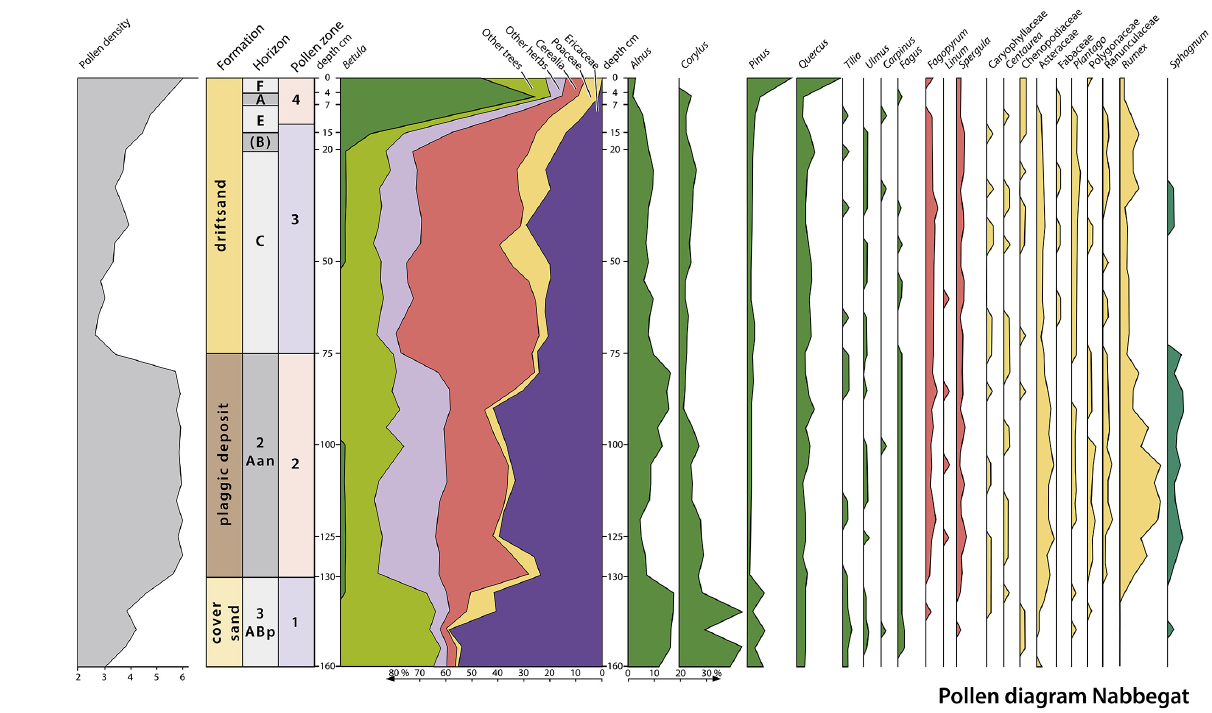
Figure 10. Pollen diagram Nabbegat. Log D = pollen density in log kgrainmL − 1 .